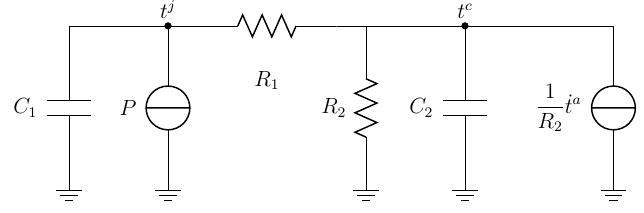
Figure 5. The proposed thermodynamic model for a generic pulsed ToF